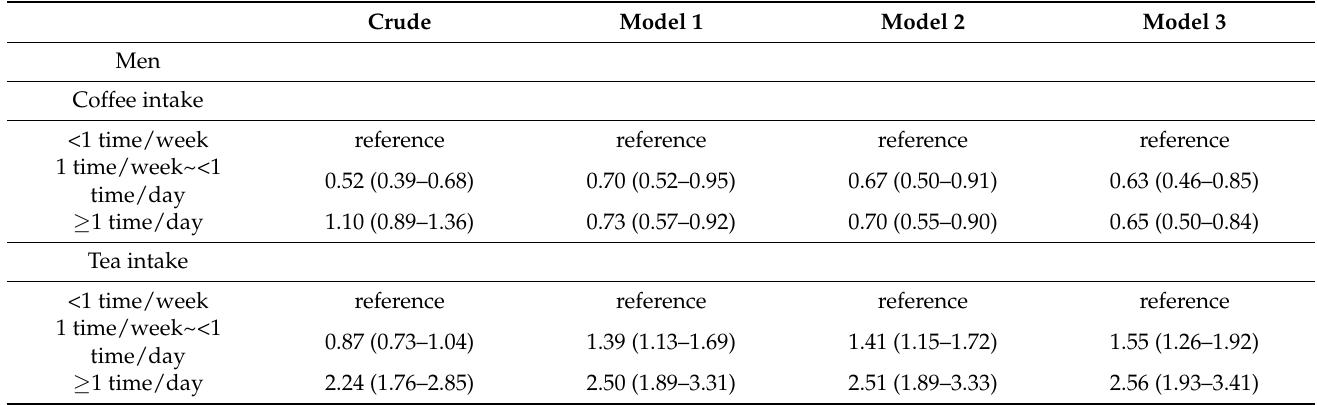
Table 3. Multivariable logistic regression for dyslipidemia according to the frequency of intake of coffee, tea, and carbonated